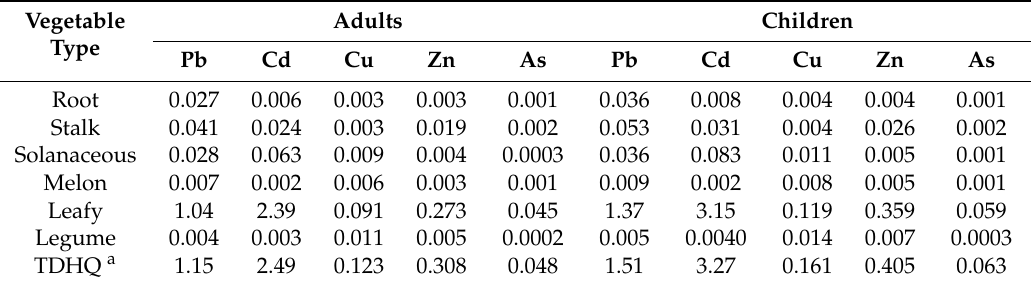
Table 4. Heavy metal target hazard quotient (THQ) values due to consumption of six vegetable types.